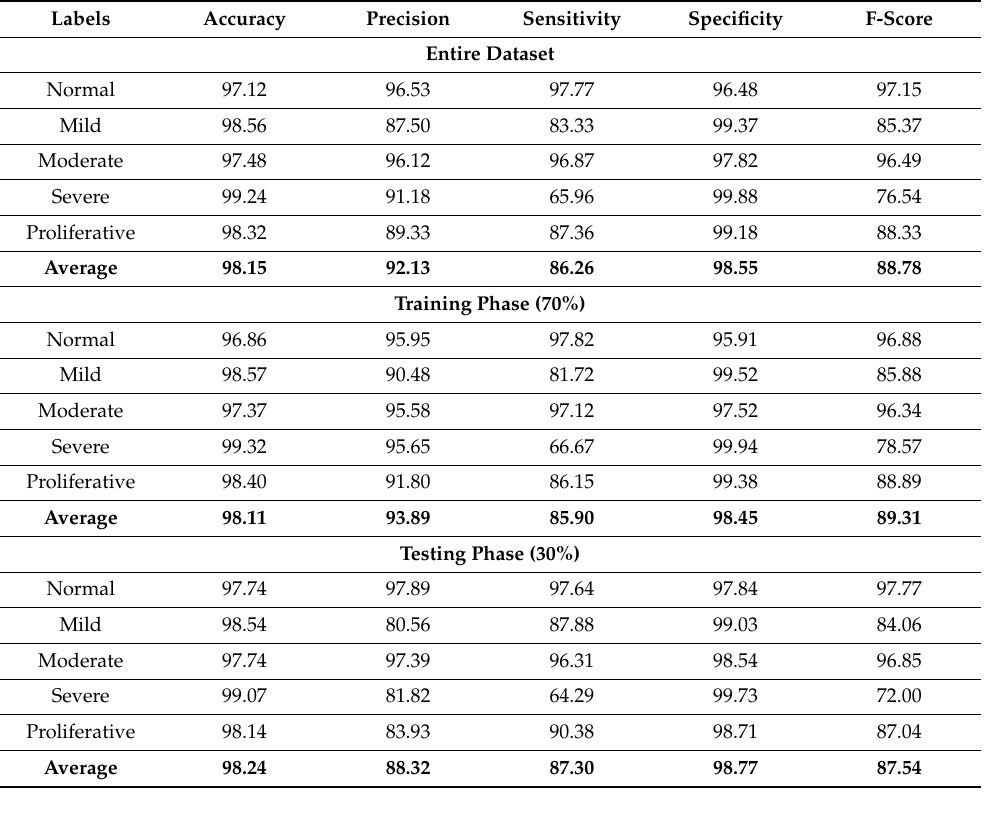
Table 4. Result analysis of the XAITO-DRGC approach with various measures on the DDR dataset.